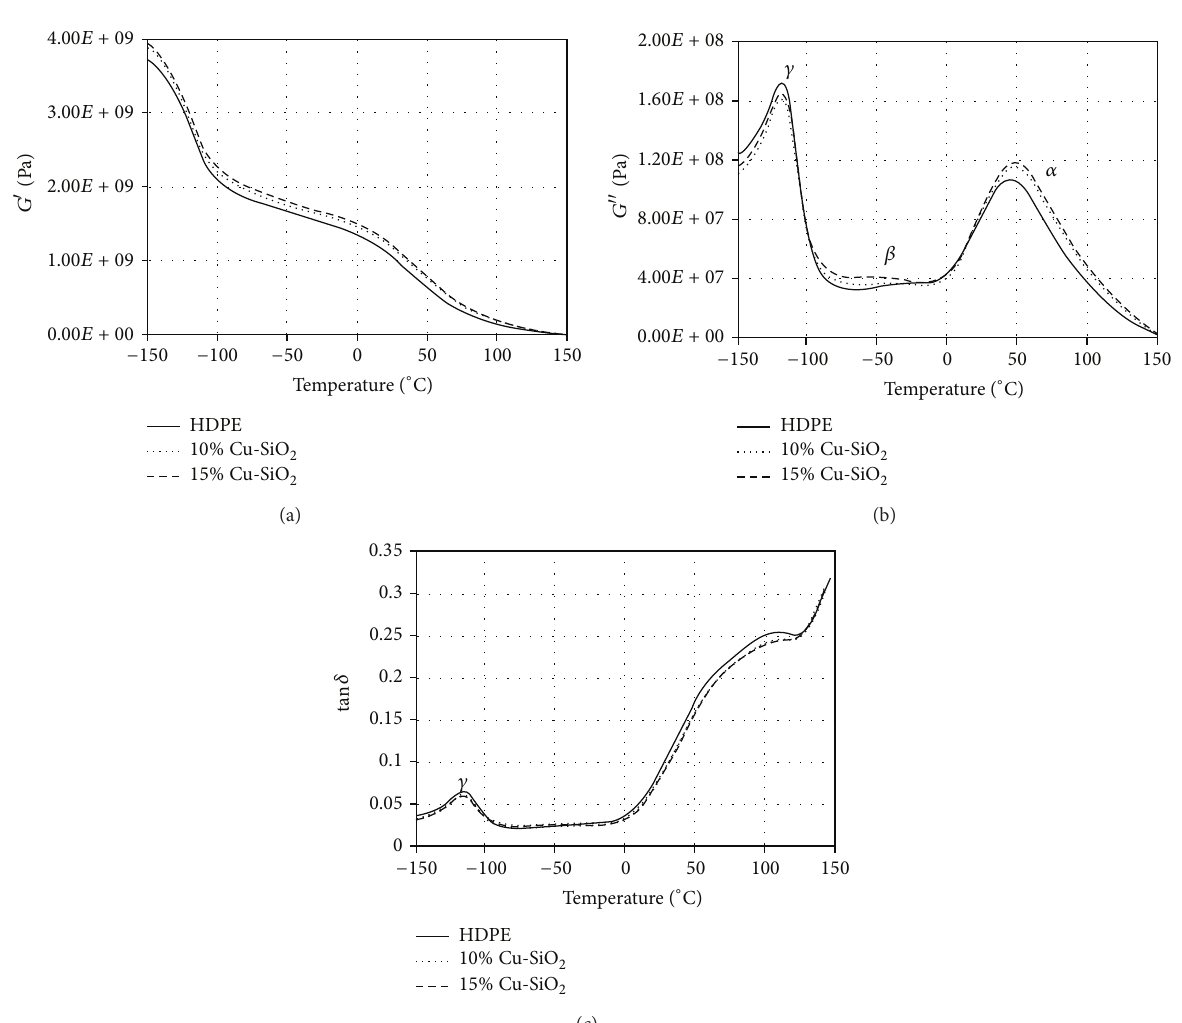
Figure 10: Dynamic mechanical relaxation behavior versustemperature of HDPE and silica containing immobilized nanocopper filled HDPE composites at frequency of 1Hz: 𝐺 󸀠 (a), 𝐺 󸀠󸀠 (b), and tan 𝛿